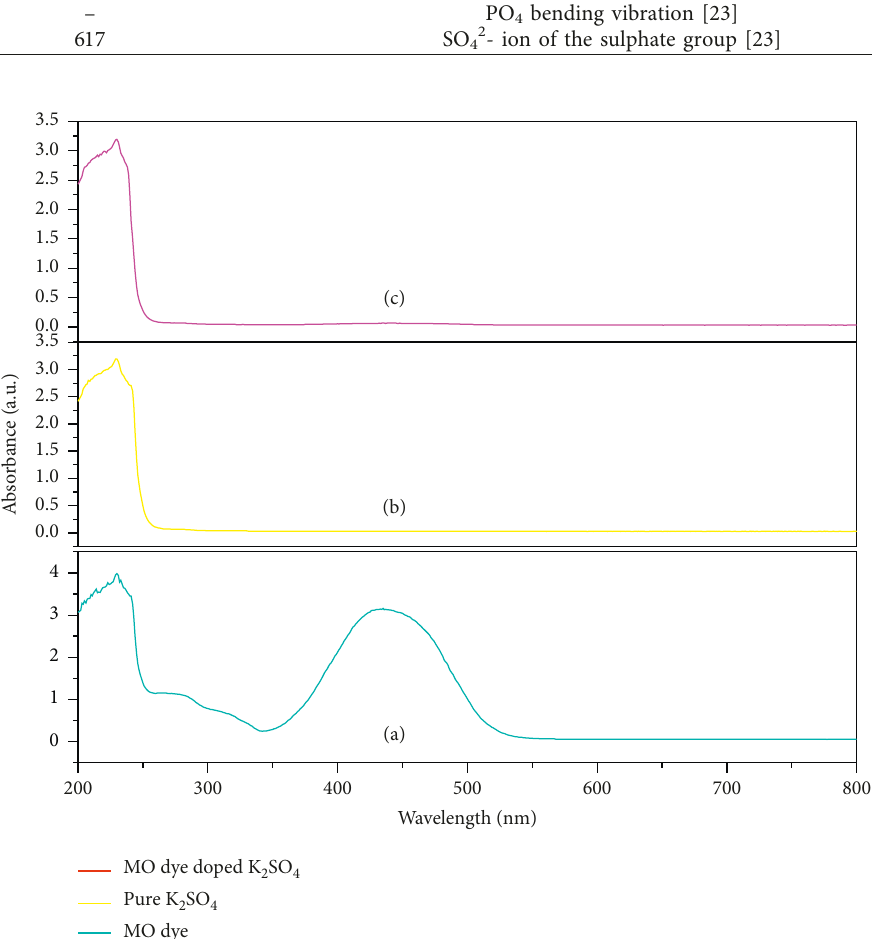
Figure 3: UV absorbance spectra of pure MO dye, pure K2SO4, and MO dye doped K2SO4 single crystal. (a) MO dye, (b) K2SO4, and (c) MO dye doped K2SO4 single